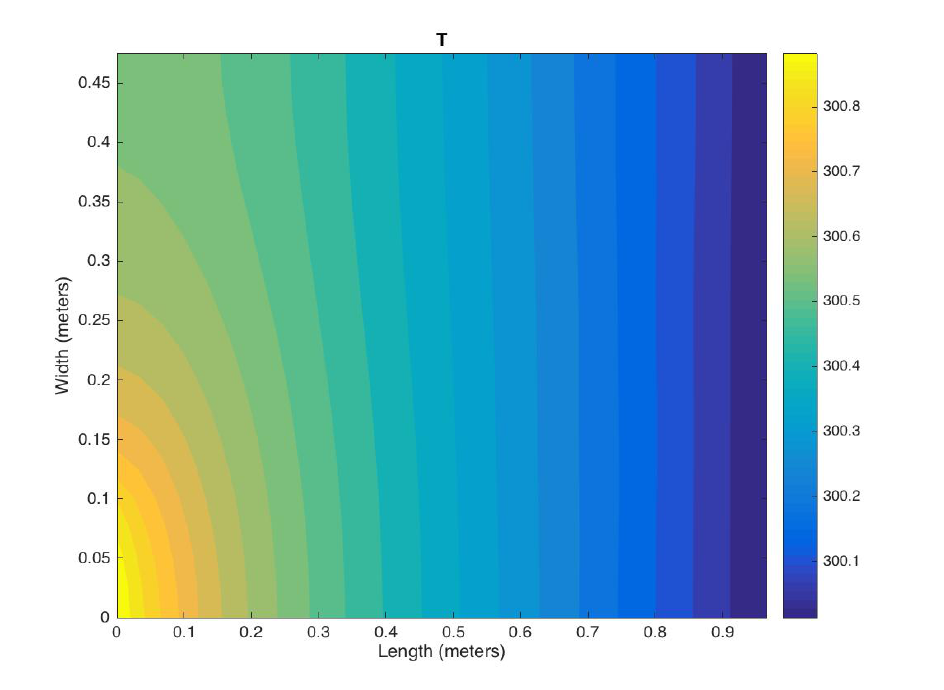
Figure 4. Distribution of the temperature on regular permeability map after 0.75